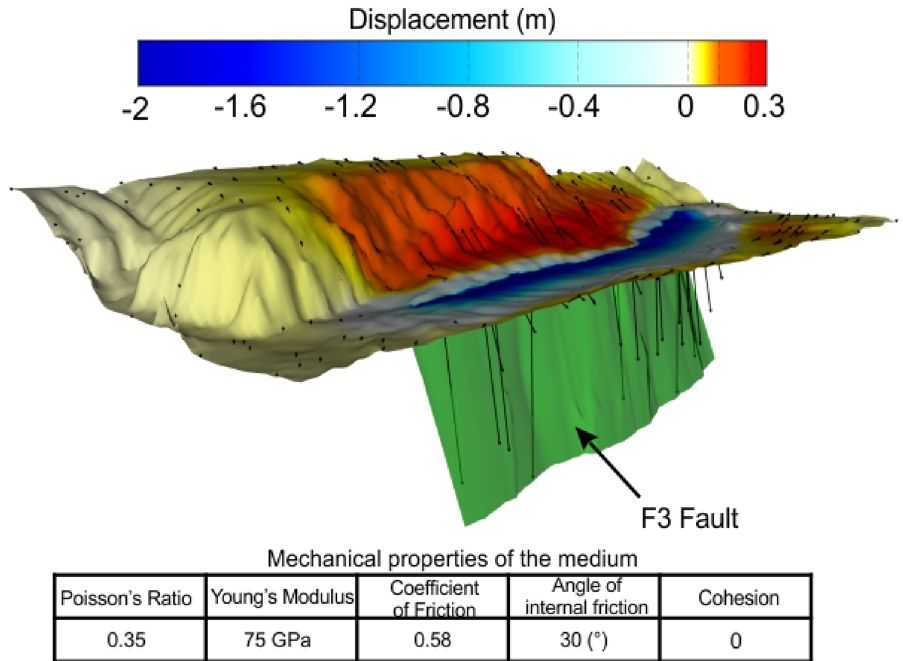
Figure 5. Fault response modelling and resulting displacement field achieved by simulating a distributed dip- slip motion of 4.8 m along the F3 fault-plane. The mechanical parameters of the medium surrounding the fault are listed in the table below. Black arrows are the calculated slip vectors. The figure was edited by co-authors through MOVE software—version 2020 12.5, https:// www. petex. com/ produ cts/ move-